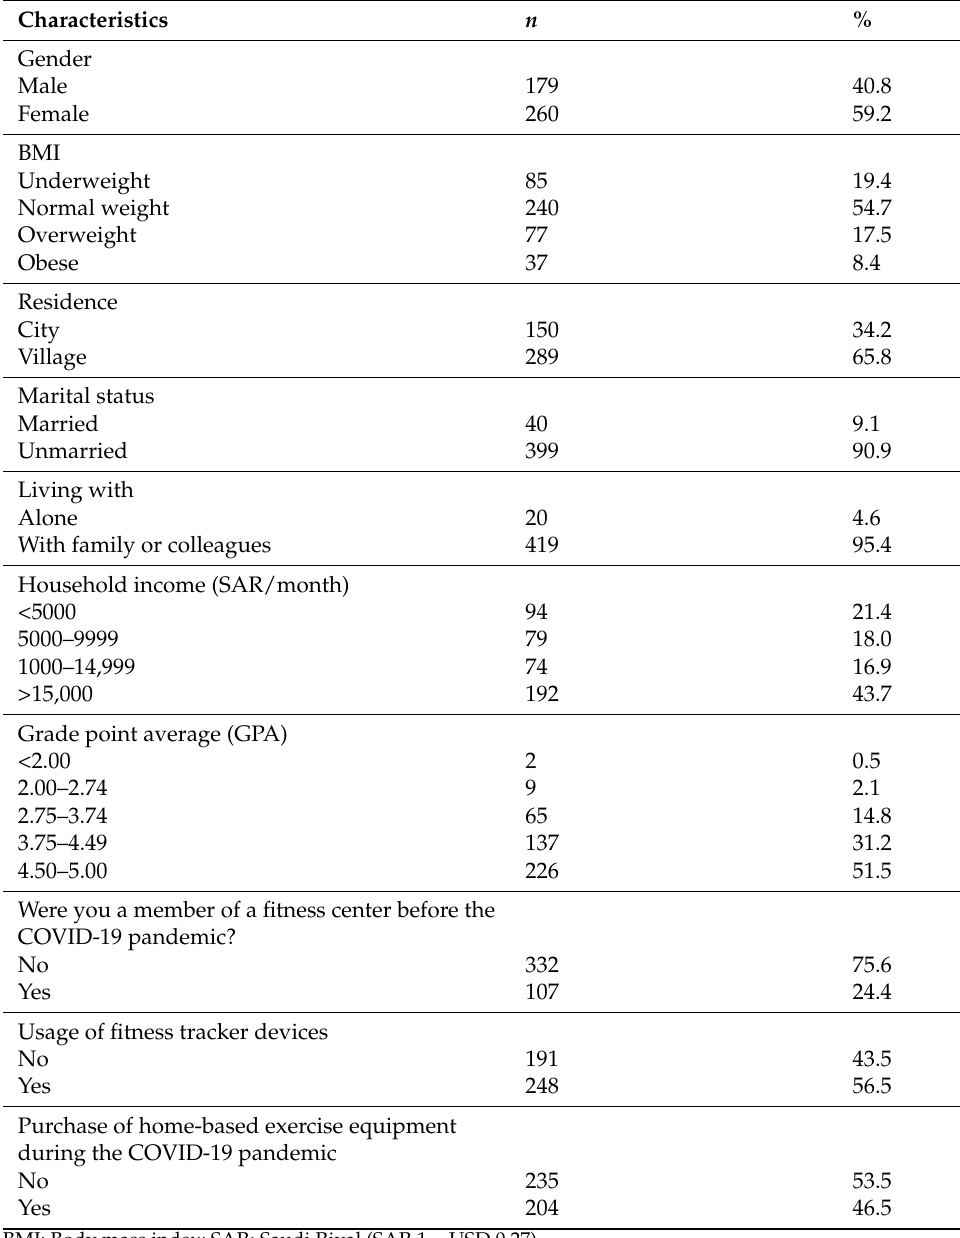
Table 1. The sociodemographic structures of the study